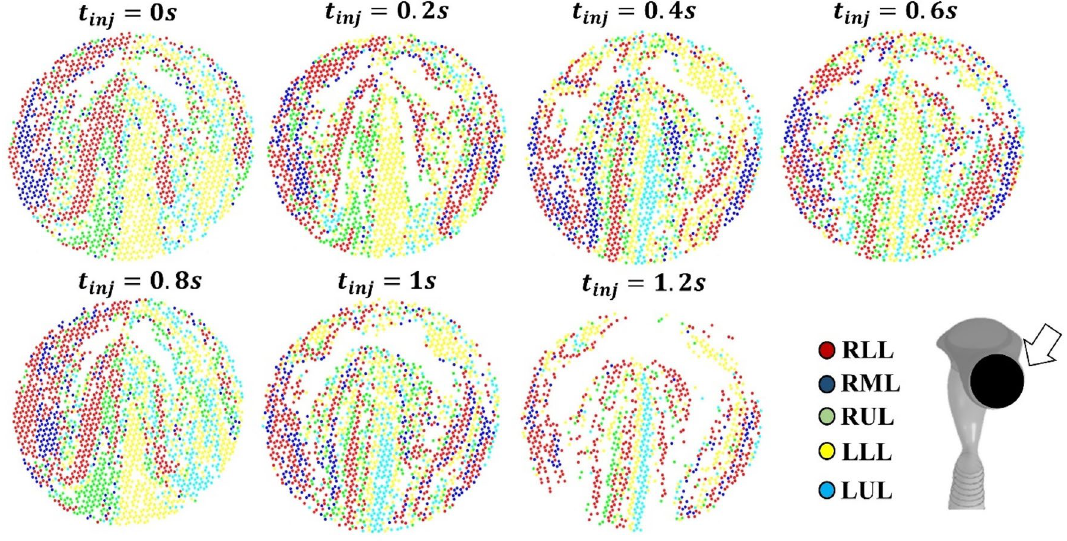
Figure 7. Transient simulation: 7 µm particle positions plot on the inlet surfaces of the mouth. Dots are aerosol particles, in the position where they are at their entrance in the model, at each indicated injection time. Colours indicate the lobes where aerosol exits from, empty regions are related to particles that either start from that position and deposit on the model internal surfaces, or remain suspended in the volume of the aerial way. (Matlab 2016-www.mathw